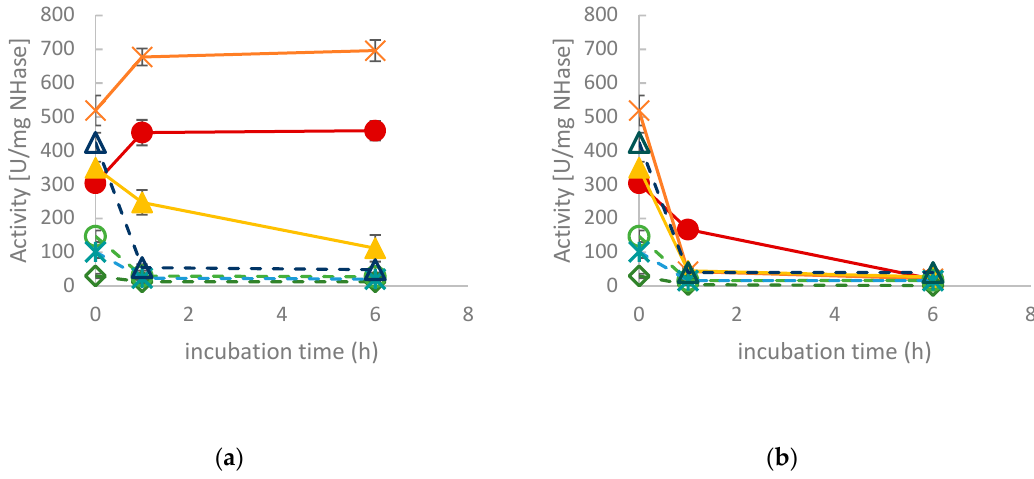
Figure 4. Residual activities of NHase CFEs for MAN hydrolysis at 25 °C. ( a ) After incubation at 37 °C in buffer at pH 8.0; ( b ) after incubation at 50 °C at pH 8.0. Ct NHase: filled dark red circles. Ko NHase: filled orange squares. Na NHase: filled yellow triangles. Gh NHase: green rhombs, dashed line. Pk NHase: light green circles, dashed line. Pm NHase: blue crosses, dashed line. Re NHase: dark blue triangles, dashed line.